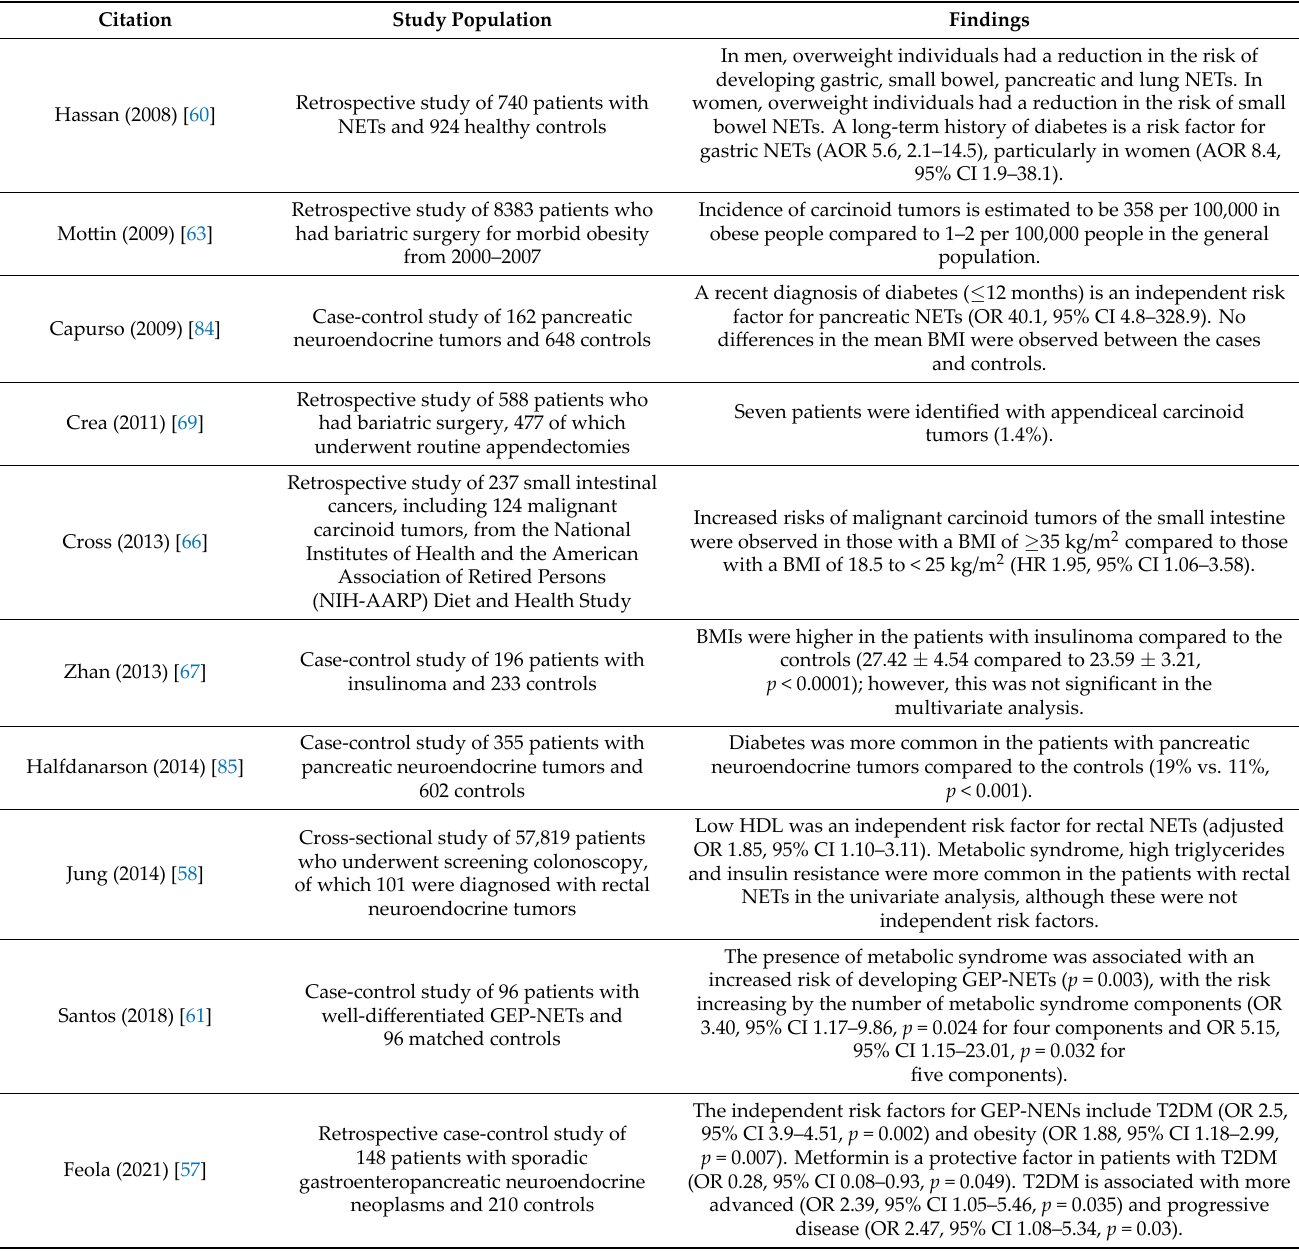
Table 1. Summary of the evidence linking obesity and metabolic syndrome to increased incidences of neuroendocrine